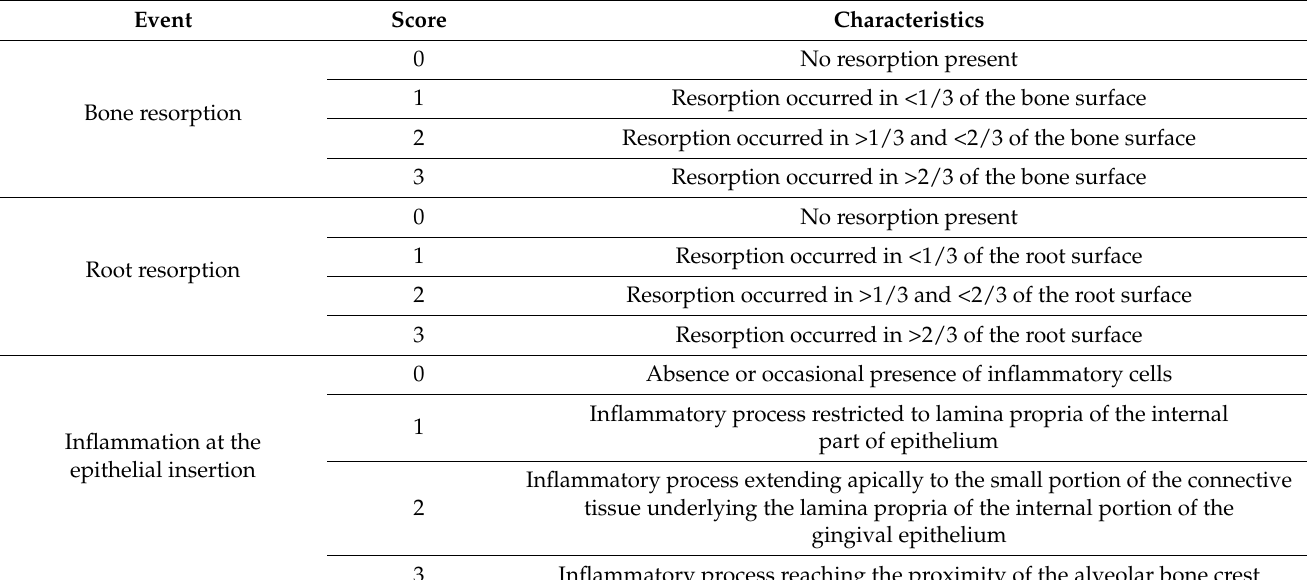
Table 3. Scores for quantitative analysis in histological